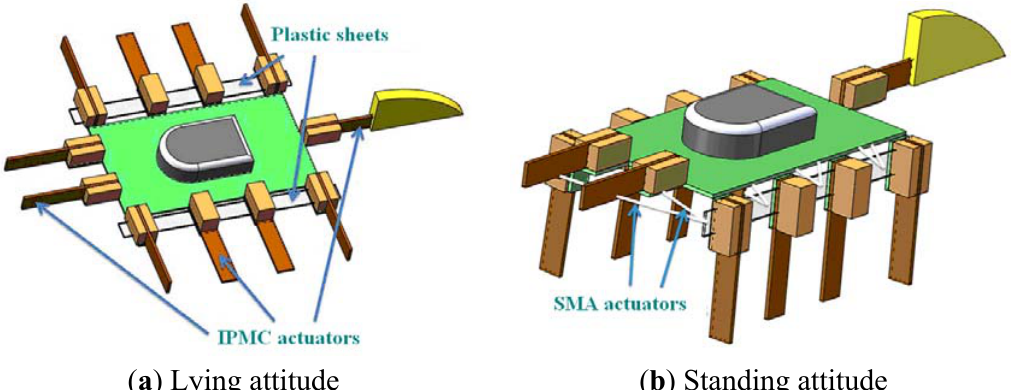
Figure 13. Proposed hybrid microrobot.